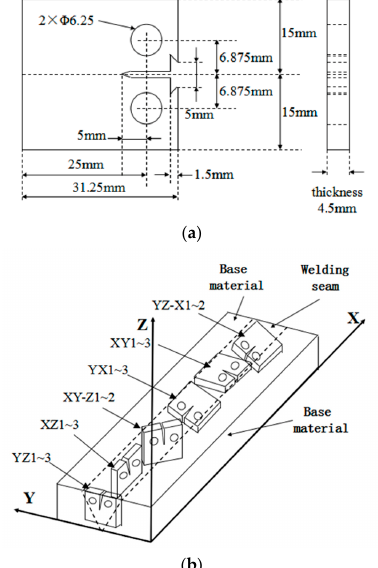
Figure 2. Size of specimens: ( a ) standard compact tension (CT) specimen; ( b ) 16 CT specimens manufactured by using welding material.